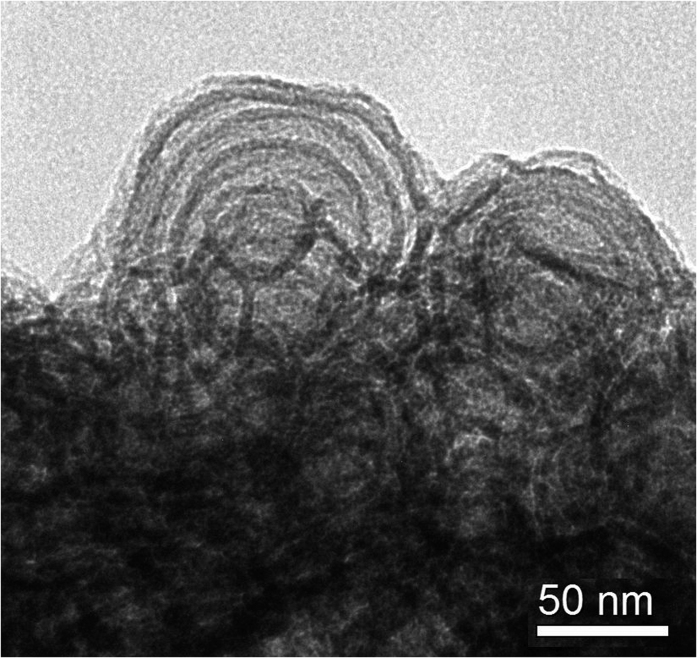
TEM image of DPMS.